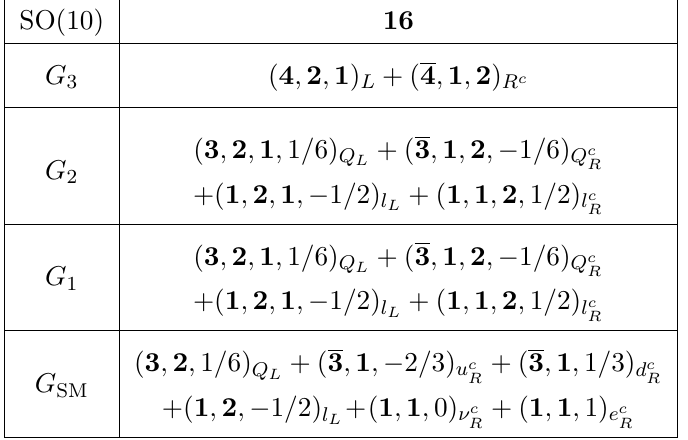
Table 3 . Decomposition of the matter multiplet 16 in each step of the breaking